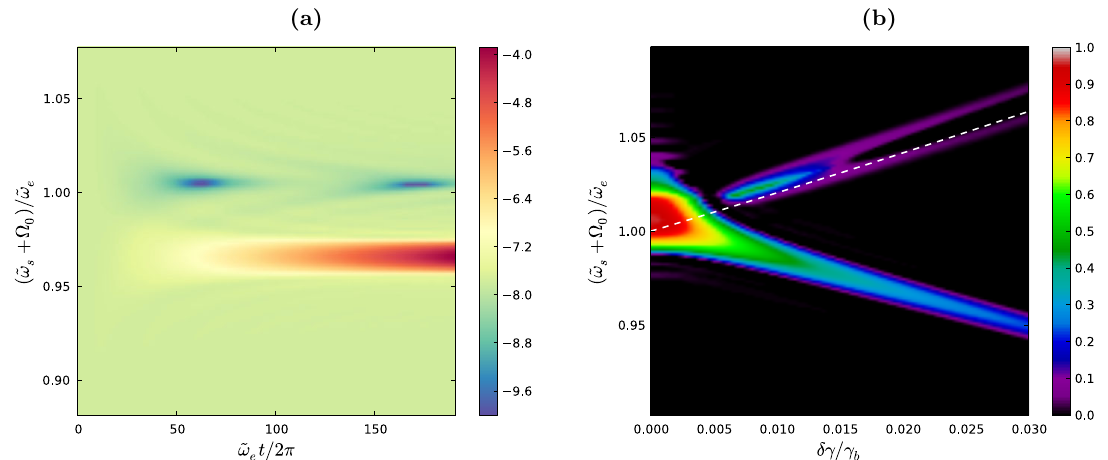
FIG. 4. (a) Temporal dynamics of the signal wave as a function of its frequency calculated numerically. The color scale is logarithmic. (b) Normalized FEL parameter ρ = ρ 0 as a function of the longitudinal temperature and the signal frequency calculated numerically for the elliptic electron mode.